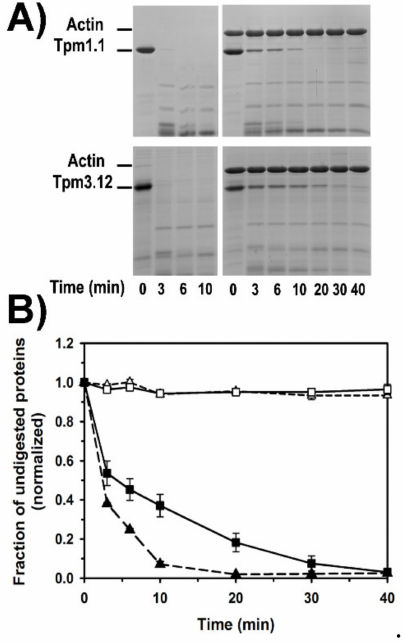
Figure 6. Tryptic digestion of tropomyosin alone and bound to F-actin. ( A ) Representative polyacrylamidegelsshowingthedigestiontimecourse. ( B )FractionofundigestedF-actininthepresence of Tpm1.1 (open triangles, dashed line), F-actin in the presence of Tpm3.12 (open squares, solid line), Tpm 1.1 in complex with F-actin (black triangles, dashed line), Tpm3.12 in complex with F-actin (black squares, solid line). Experimental conditions: 5 µ M F-actin, 2 µ M Tpm1.1 or Tpm3.12 in 5 mM Hepes, 100 mM NaCl, 2 mM MgCl 2 , 0.2 mM ATP, pH 7.6. Trypsin was at 1:50 w / w actin ratio. Experimental points are averages from three independent experiments ± SE. Analysis of statistical significance of di ff erences between the experimental groups in ( B ) (F-actin, F-actin-Tpm1.1, and F-actin-Tpm3.12) showed that the di ff erences were significant at time range from 3 to 20 min ( p < 0.05); at 30 and 40 min the di ff erences were not significant ( p >